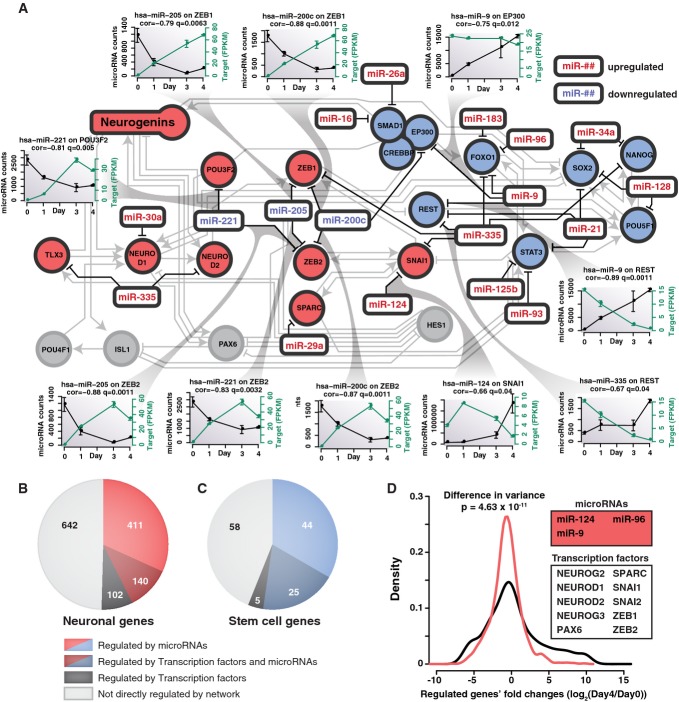
miRNAs contribute to the gene regulatory networkA Validated transcription factor targets for differentially expressed miRNAs were identified from
miRTarBase. The miRNA interactions (black) have been superimposed on the previously generated
regulatory network (light gray). Most interactions involved upregulated miRNAs that suppress stem
cell factors in our network. Inset plots show cases with significant anticorrelation between miRNAs
(green) and their transcription factor targets (black).B, C The miRNAs and transcription factors regulate many additional downstream (B) neuronal and
(C) stem cell genes during iNGN differentiation. Neuronal and stem cell genes were determined based
on GO terms listed in Supplementary Table S7.D The fold changes of downstream-regulated genes by neuronal miRNAs (red) and selected neuronal
transcription factors in our network (black) were compared and indicated that regulation by
transcription factors exhibits a higher impact, that is, broader range of fold change, than seen for
miRNA targets (Levene's test).